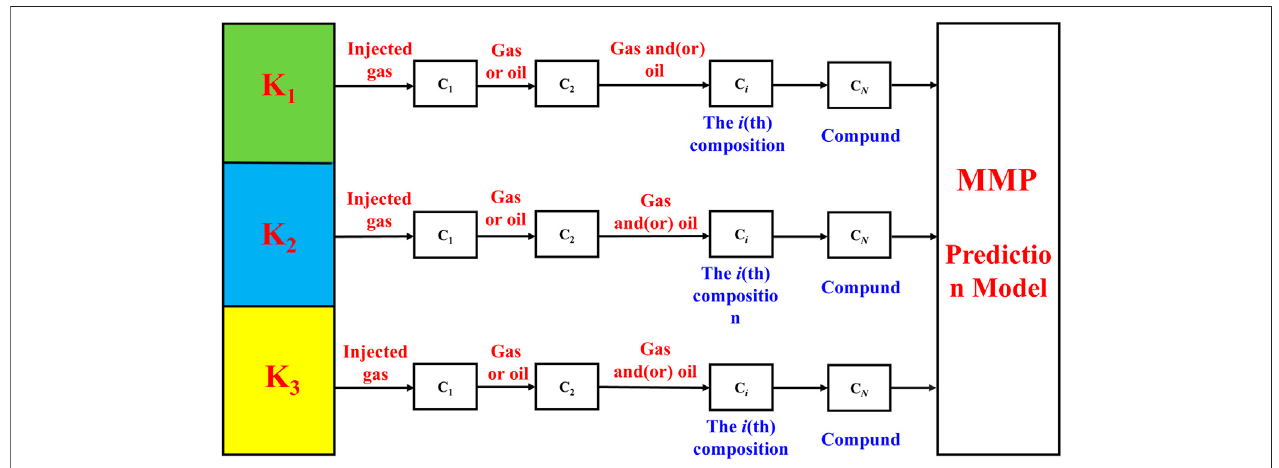
FIGURE 3 | The microscopic heterogeneity model established in this